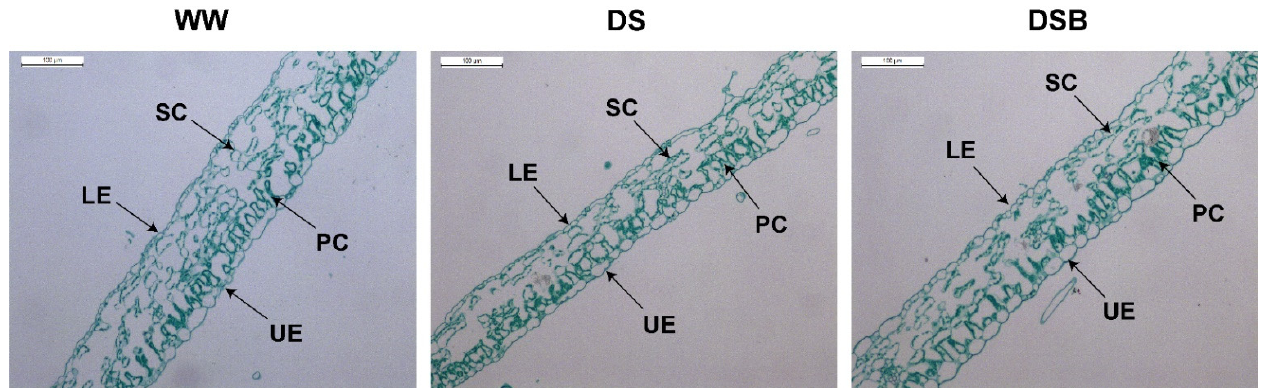
Figure 1. Representative leaf structure images under 2,4 ‐ epibrassinolide (EBR) application in response to drought stress. WW (well ‐ watered), DS (drought stress), and DSB (drought stress + 0.05 mM EBR application) are the three treatments. LE — lower epidermis, UE — upper epidermis, PC — palisade cells, SC — spongy cells.